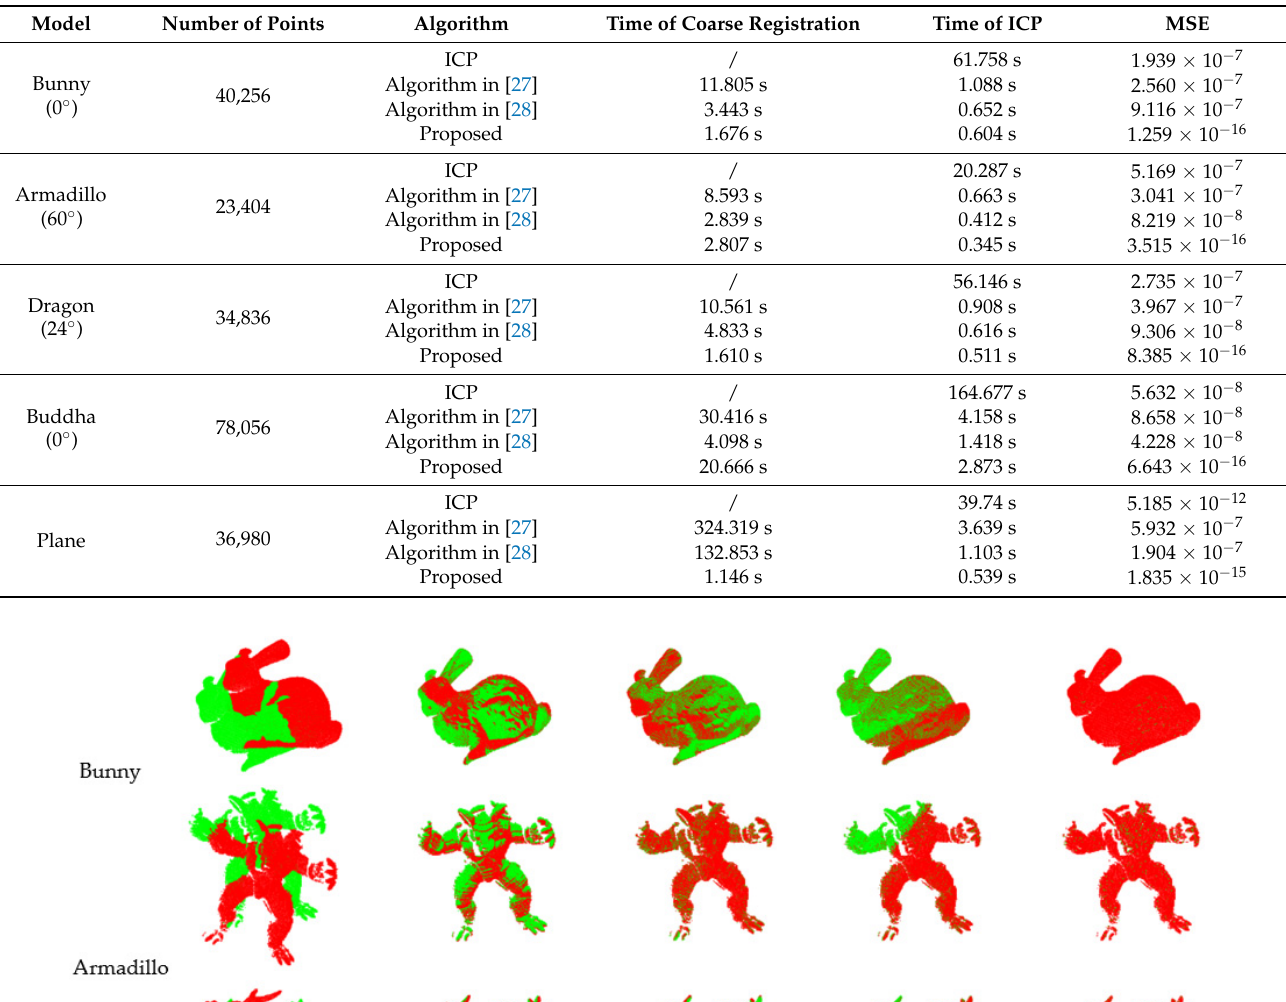
Table 3. Registration results from the same angle.